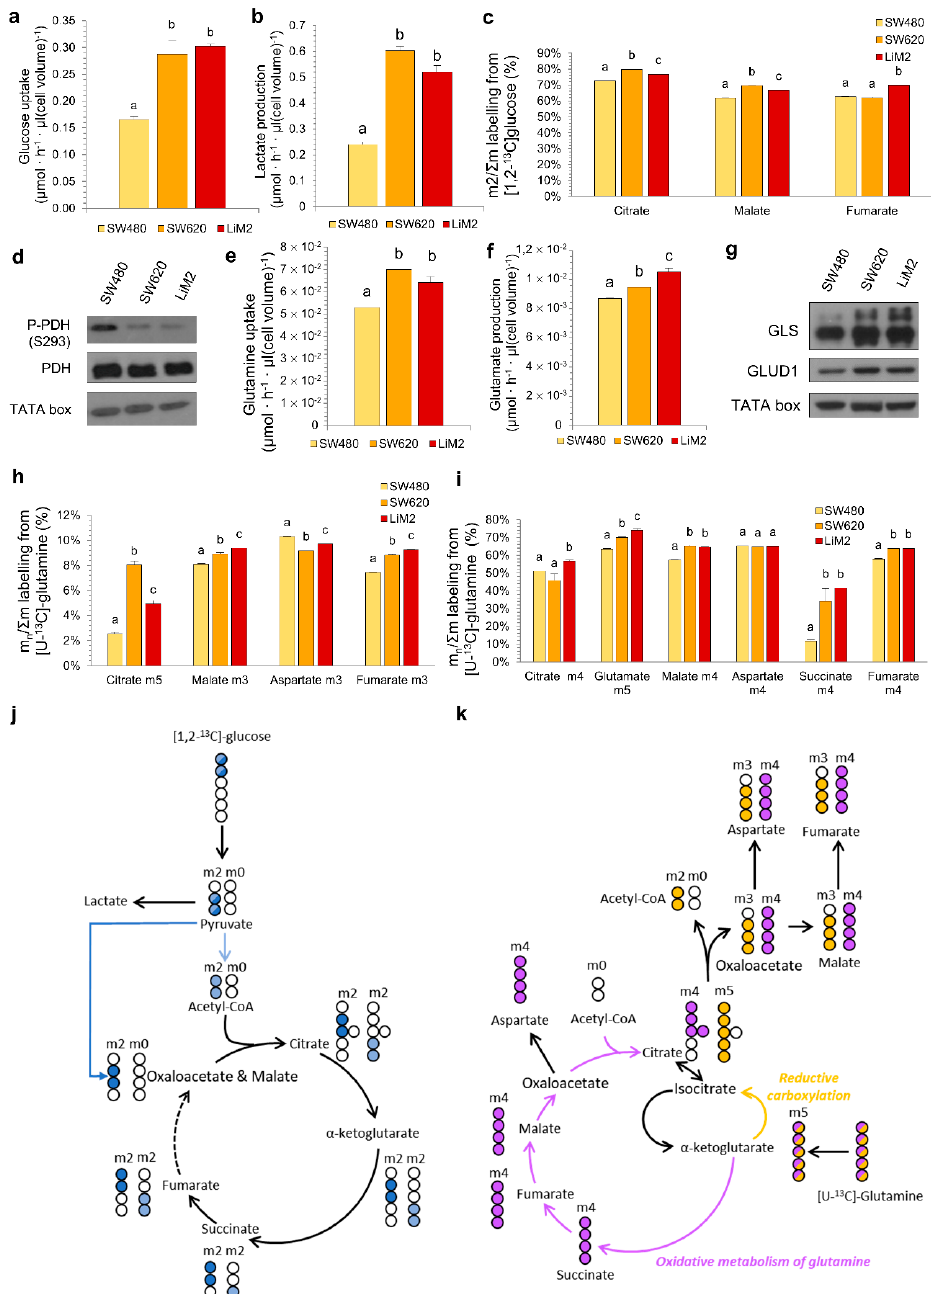
Figure 2. The metastatic cell lines display higher metabolic flexibility with an increased glucose and glutamine metabolism. ( a ) Glucose uptake and ( b ) lactate production rates after 48 h of cell culture. ( c ) Glucose contribution to TCA cycle after 24 h incubation with 10 mM [1,2- 13 C]-glucose. ( d ) P-PDH (phosphorylated Pyruvate Dehydrogenase) and total PDH protein levels tested by western blotting. TATA box was used as a loading control. ( e ) Glutamine uptake and ( f ) glutamate production rates after 48 h of cell culture. ( g ) GLS (glutaminase), GLUD1 (glutamate dehydrogenase 1) protein levels tested by western blotting. ( h ) and ( i ) Glutamine contribution to TCA cycle measured after 24 h incubation with 4 mM [U- 13 C]-glutamine, representing ( h ) reductive carboxylation and ( i ) oxidative metabolism of glutamine. ( j ) Graphical representation of the 13 C (in blue) and 12 C (in white) incorporation to TCA intermediaries from [1,2- 13 C]-glucose. Only the formation of m2 isotopologues in the first turn of the cycle is shown. ( k ) Graphical representation of the 13 C (coloured) and 12 C (in white) distribution to intracellular TCA intermediaries by oxidative carboxylation (purple) or reductive carboxylation (orange) from [U- 13 C]-glutamine in the first turn of the cycle. a,b,c A one-way ANOVA and Scheffe’s test for multiple comparisons was performed for the factor “cell